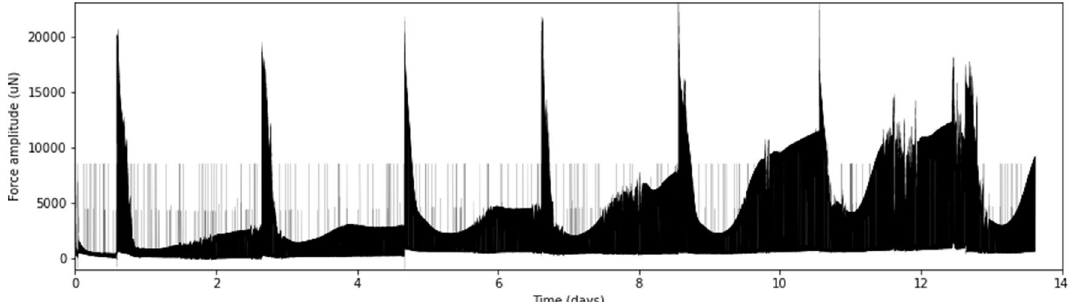
Figure 2. Exemplary contractility traces of an atrial tissue slice for 14 days in cultivation. Culture medium was refreshed every two days with subsequent isoprenaline administration, characterized by short-term increases in twitch force amplitude. Experimentation was stopped on day 14 of biomimetic cultivation.